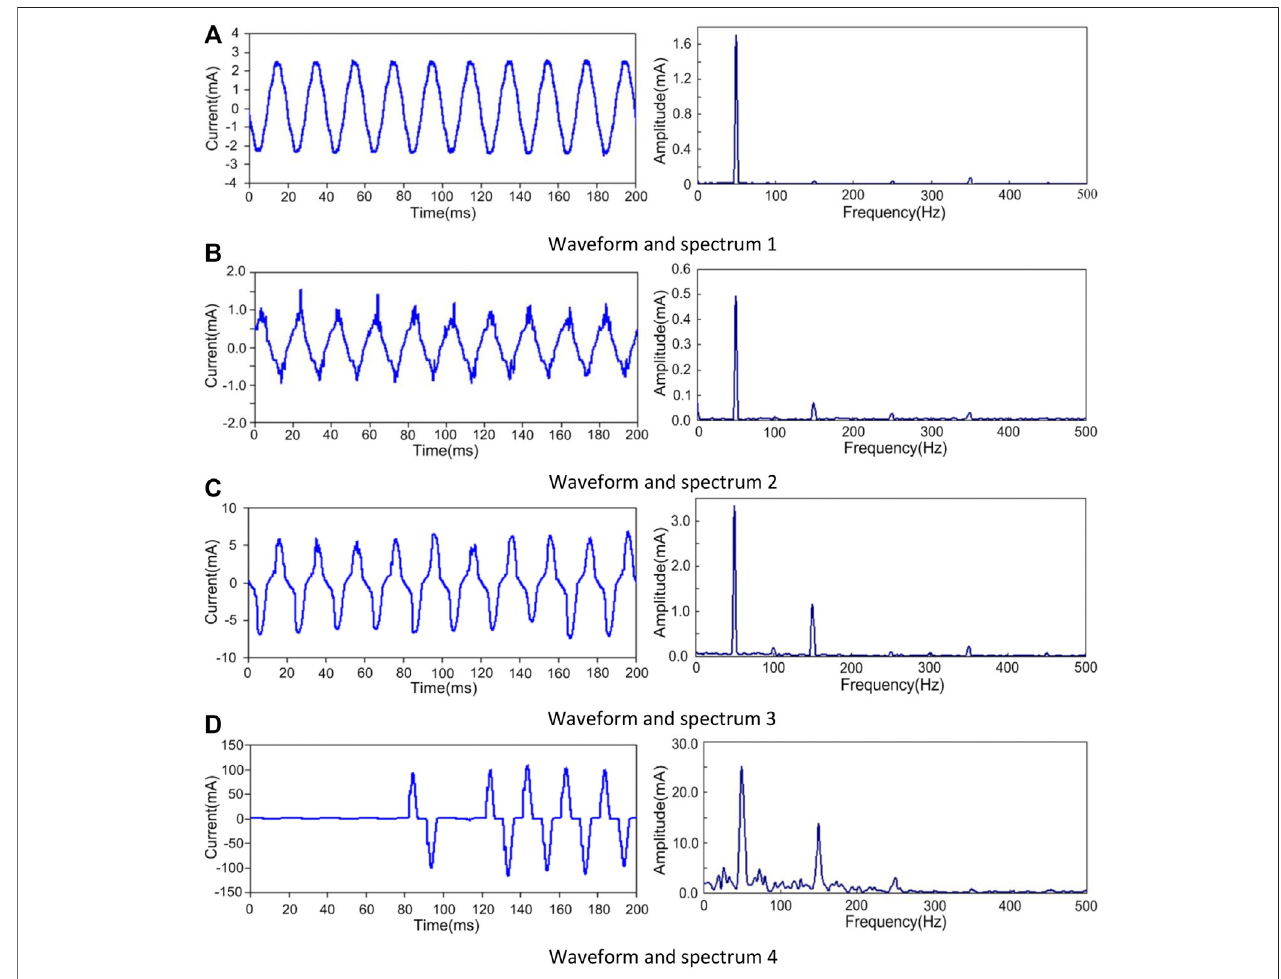
FIGURE 4 | LC waveforms and frequency spectrum of different discharging strength.